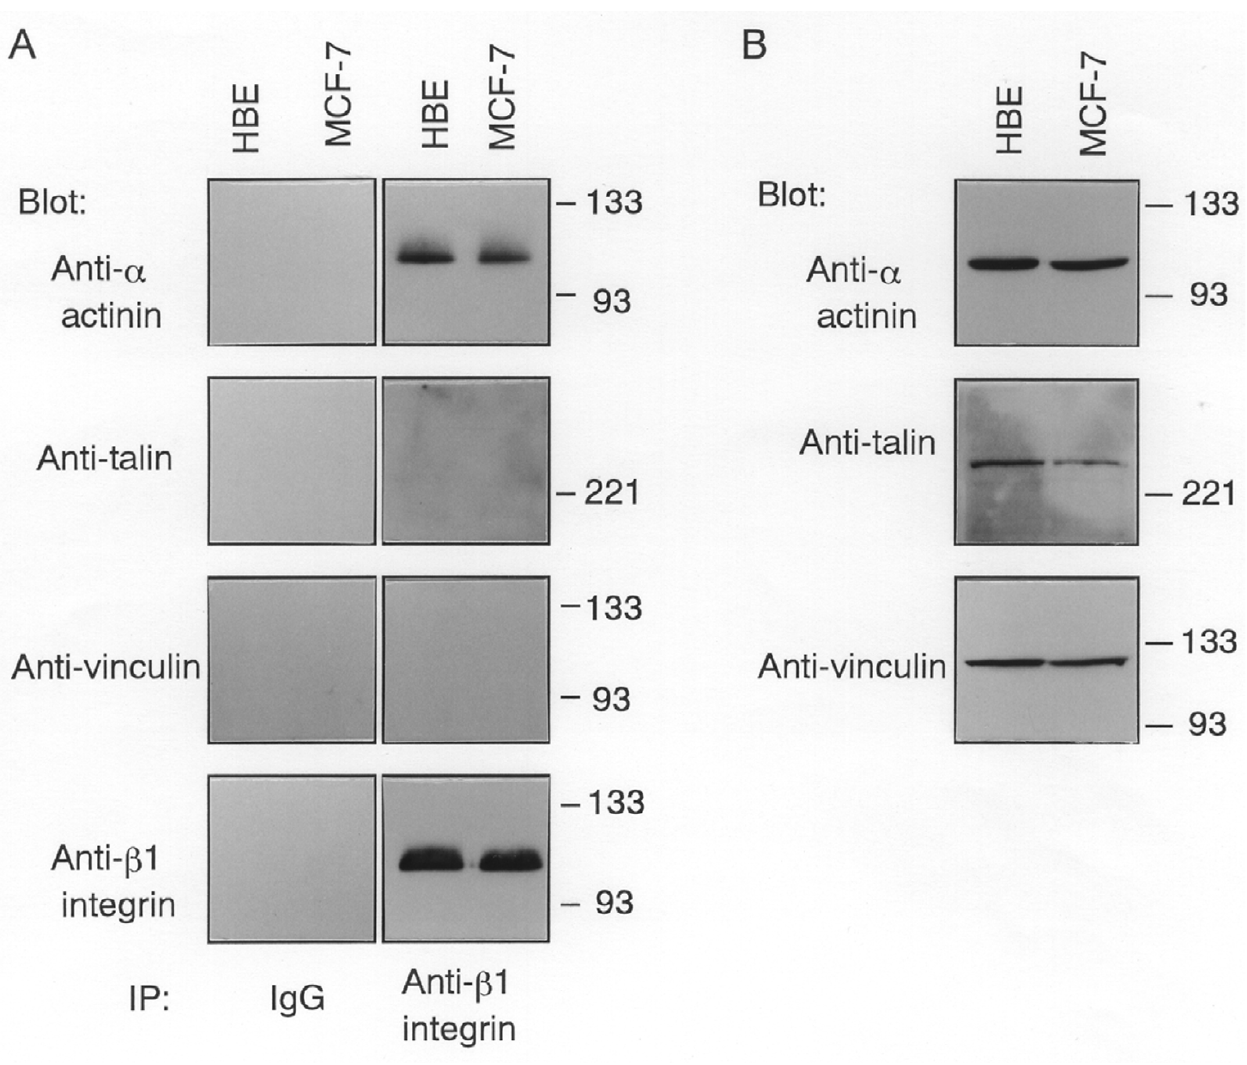
Figure 2 Coprecipitation of α -actinin, but not talin or vinculin, with β 1 integrin in HBE and MCF-7 cells. (A) Integrin β 1 was immunoprecipitated (IP) from HBE and MCF-7 cells using the anti- β 1 integrin antibody or control IgG. The immunoprecip- itates were probed with anti- α -actinin, anti-talin, or anti-vinculin antibody. Molecular size markers are indicated at right in kDa. (B) Equal amounts (5 µ g protein) of whole cell lysates from quiescent HBE and MCF-7 cells were probed with anti- α -actinin, anti-talin, or anti-vinculin antibody. Molecular size markers are indicated at right in